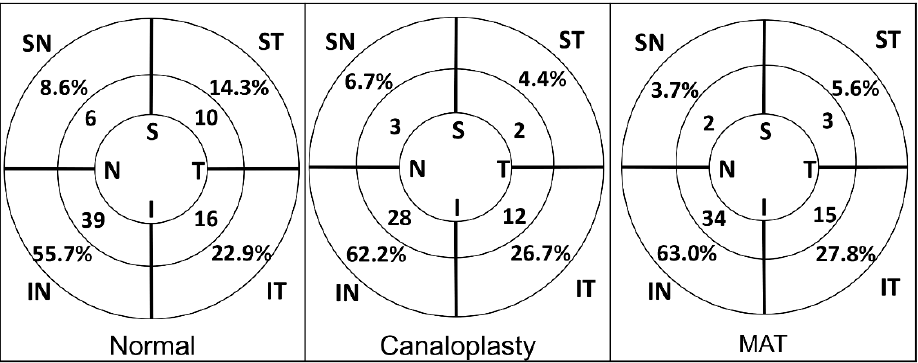
Figure 1. Aqueous vein distribution in eyes. Note: MAT: microcatheter assisted trabeculotomy; IT: inferior temporal; IN: inferior nasal; ST: superior temporal; SN: superior nasal.